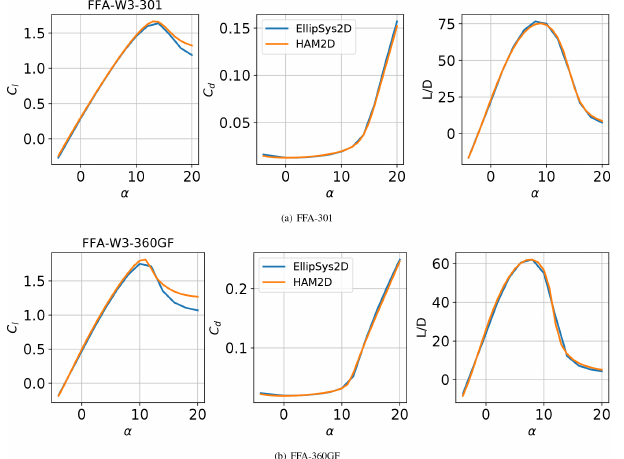
Figure 3. Comparison of aerodynamic performance predicted by HAM2D using the SA turbulence model with that from EllipSys2D using the k – ω SST turbulence model (Bak et al., 2013) under fully turbulent flow assumptions at a Reynolds number of 10